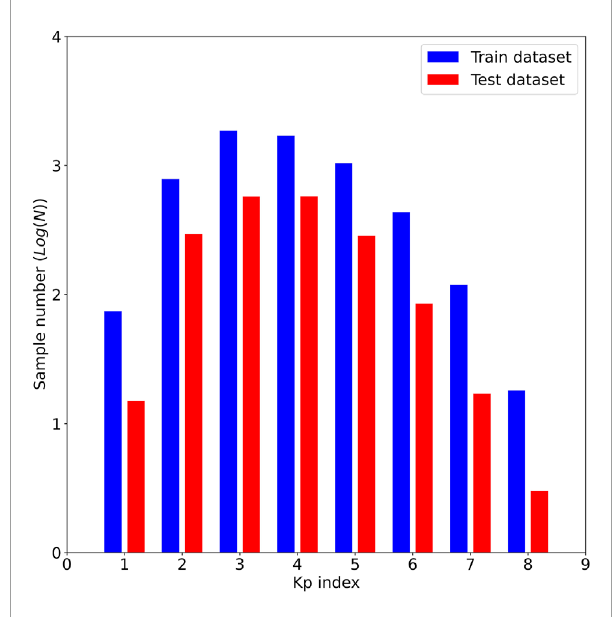
FIGURE 4 Sample distribution histogram at the training and testing subsets. The x -axis represents the maximum value of the 3-day Kp output for each sample. The y -axis represents the sample number.